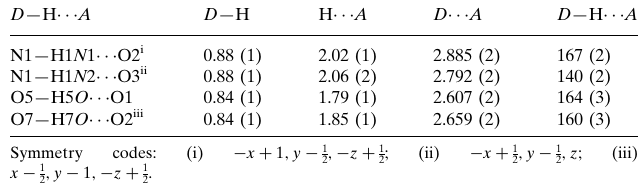
Hydrogen-bond geometry (A˚ , (cid:4)